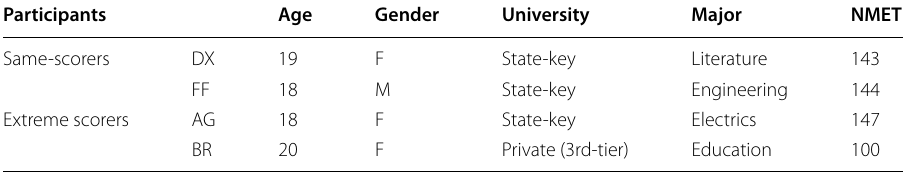
Table 2 The biodata and NMET scores of the four participants selected Participants